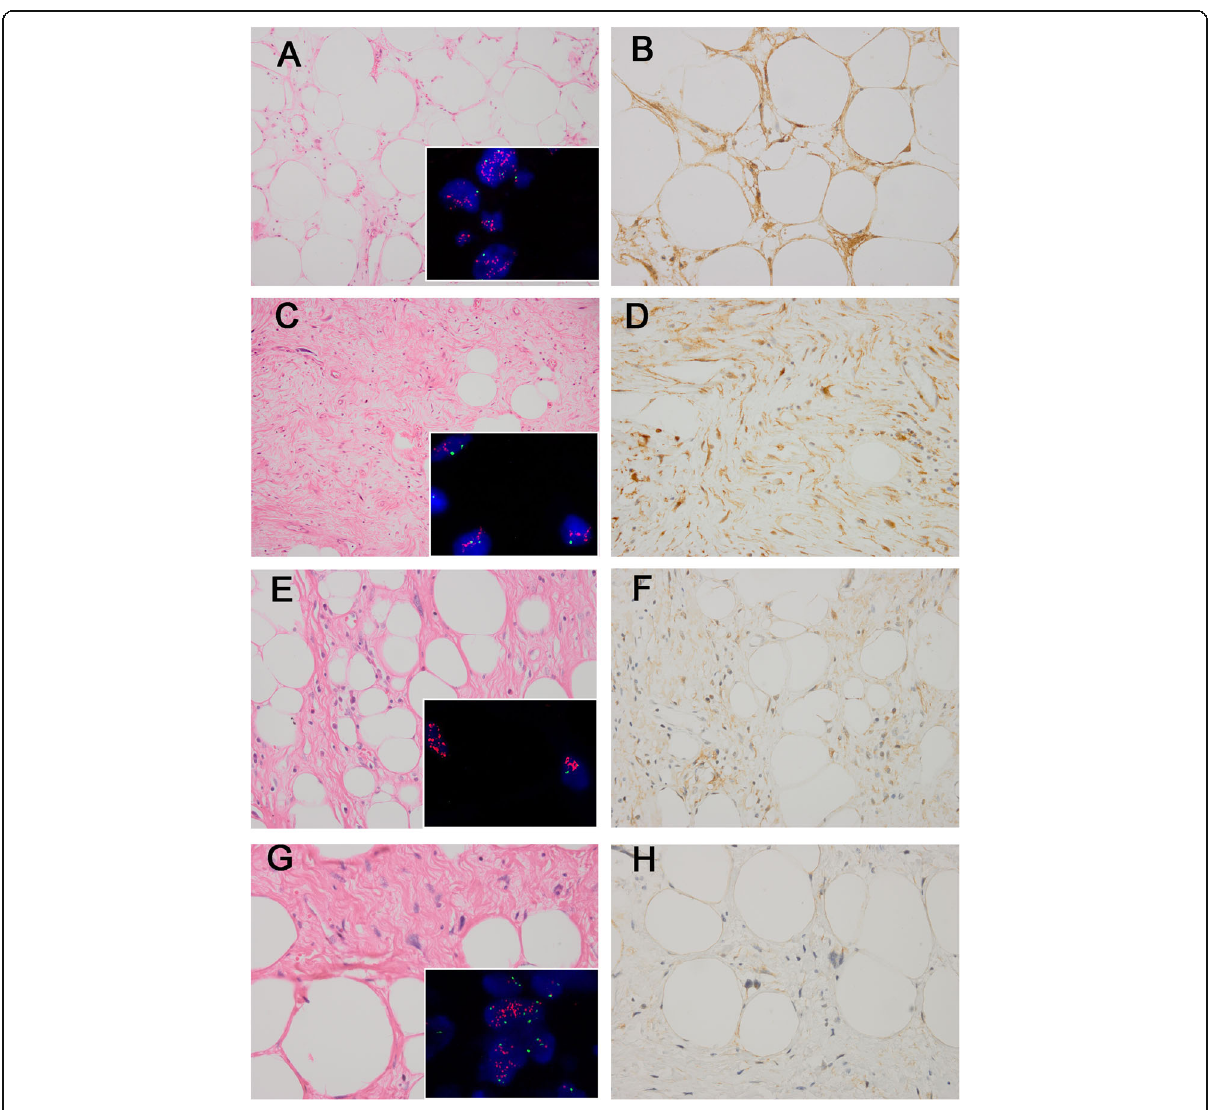
Fig. 1 The histologic features of ALT/WDLs and corresponding FRS2 FISH and FRS2 immunostaining results. Lipoma-like ALT/WDL( a ) with FRS2 amplification ( inset ), showing 3+ FRS2 expression with diffuse and strong cytoplasmic staining ( b ). Sclerotic ALT/WDL( c ) showing FRS2 amplification ( inset ), displayed 3+ FRS2 immunostaining, with strong FRS2 protein expression ( d ). Lipoma-like ALT/WDL( e ) with FRS2 amplification ( inset ), exhibited 2+ cytoplasmic staining for FRS2 ( f ). Sclerosing ALT/WDL ( g ) with FRS2 amplification ( inset ), showing 1+ FRS2 positivity ( h ). Red signals represent FRS2 . Green signals represent chromosome 12 centromeres. (a, c, e, g, haematoxylin and eosin; b, d, f, h, immunostaining) (original magnification, a, c × 200, b, d-h ×